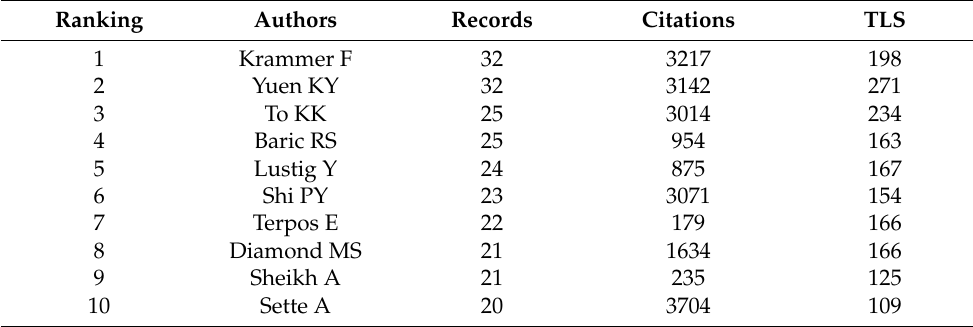
Table 3. Top 10 most prolific authors on COVID-19 vaccine research.